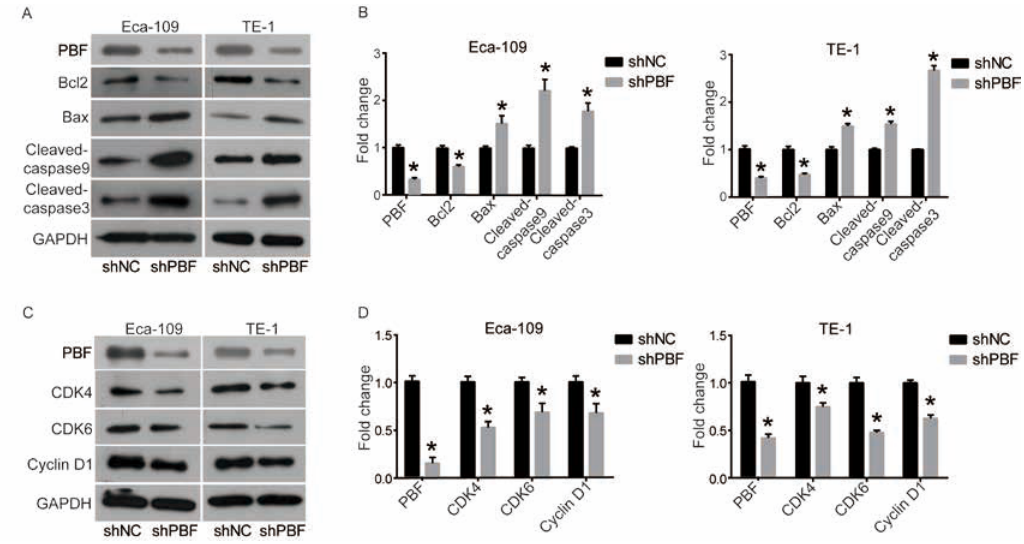
Figure 4: Down-regulation of PBF inactivates mitochondrial apoptosis pathway and repressed cell cycle regulators. (A) and (B) The members of Mitochondrial apoptosis pathways, including Bcl2, Bax, Cleaved-caspase9 and Cleaved-caspase3, were detected by western blot and quantified in density by ImageJ software; (C) and (D) Cell cycle regulators, including Cyclin D1, CDK4 and CDK6, were detected by western blot and quantified in density by ImageJ software. All experiments were repeated 3 times. *P represented significant difference.